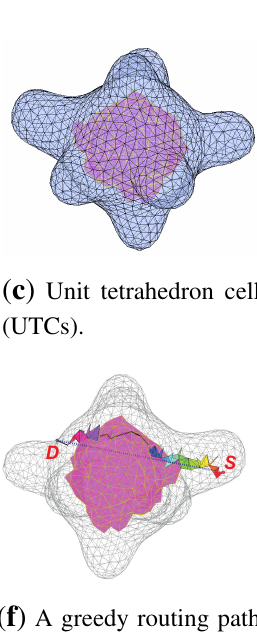
Figure 1. Illustration of the proposed greedy routing protocol. ( a ) A 3D sensor network that has irregular outer and inner boundaries and consists of about 2 , 000 nodes. This is one of the network models used in our simulation (see Figures 6 and 8 for other network models). The nodes on the inner boundary are highlighted in red. ( b ) The nodes that are local minimums under node-based greedy routing are highlighted as blue squares and red triangles, for boundary nodes and internal nodes, respectively. ( c ) The established unit tetrahedron cells (UTCs). ( d ) The result after volumetric harmonic mapping, with both outer and inner boundaries mapped to spheres. ( e) A greedy routing path shown in virtual coordinates created by volumetric harmonic mapping. ( f ) The greedy routing path shown in the original